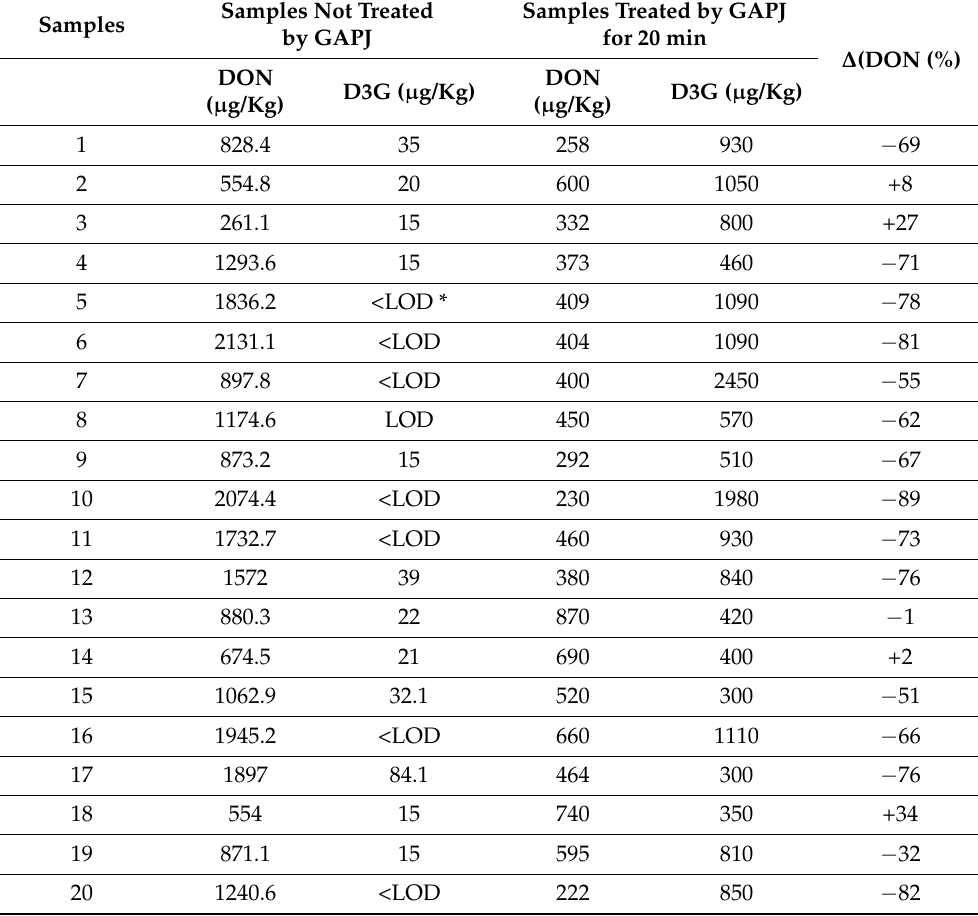
Table 3. Levels of deoxynivalenol (DON) and deoxynivalenol-3 glycoside (D3G) in naturally contam- inated barley samples and after GAPJ treatment for 20 min. Samples Not Samples